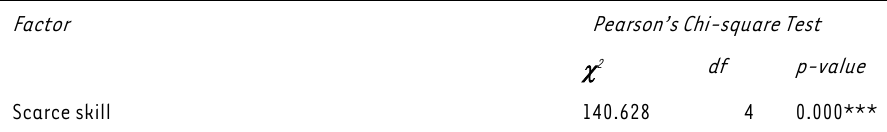
TABLE 9: Analysis of the effect of being employed in a scarce skill on household net equity quintiles Factor Pearson’s Chi-square Test Scarce